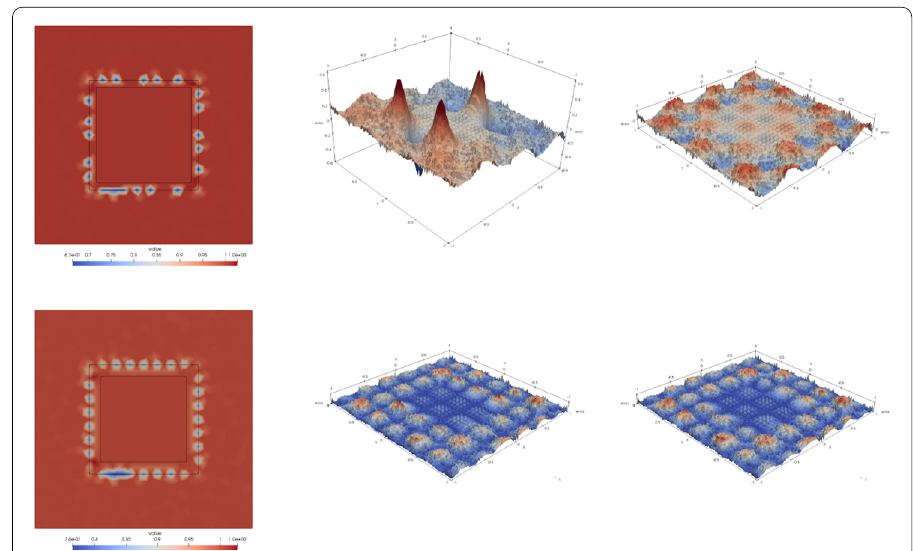
Fig. 2 Contour plots of the prolongation errors (left) attained for the constant function when using the weighted space (cid:6) HOST V HOST in the AMG construction of the prolongation P J large overlap region (bottom). Surface plots of the prolongation error of the smooth